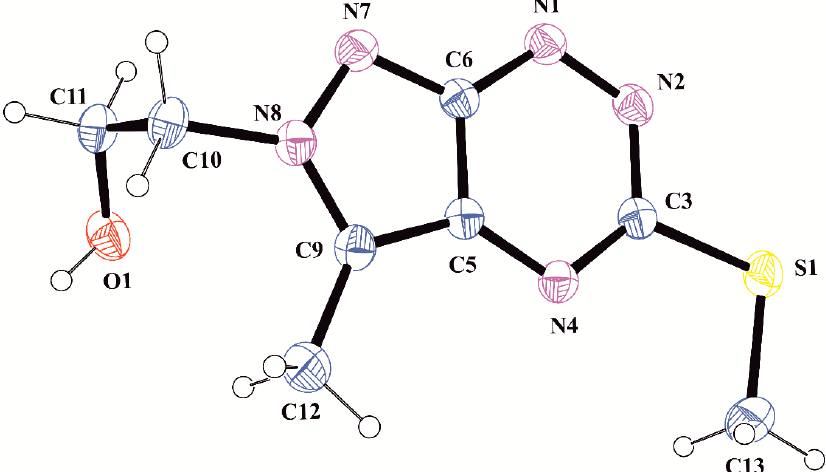
Figure 3. A view of the molecule ( 3 ), showing the atom-numbering scheme. Displacement ellipsoids are drawn at the 50% probability level.